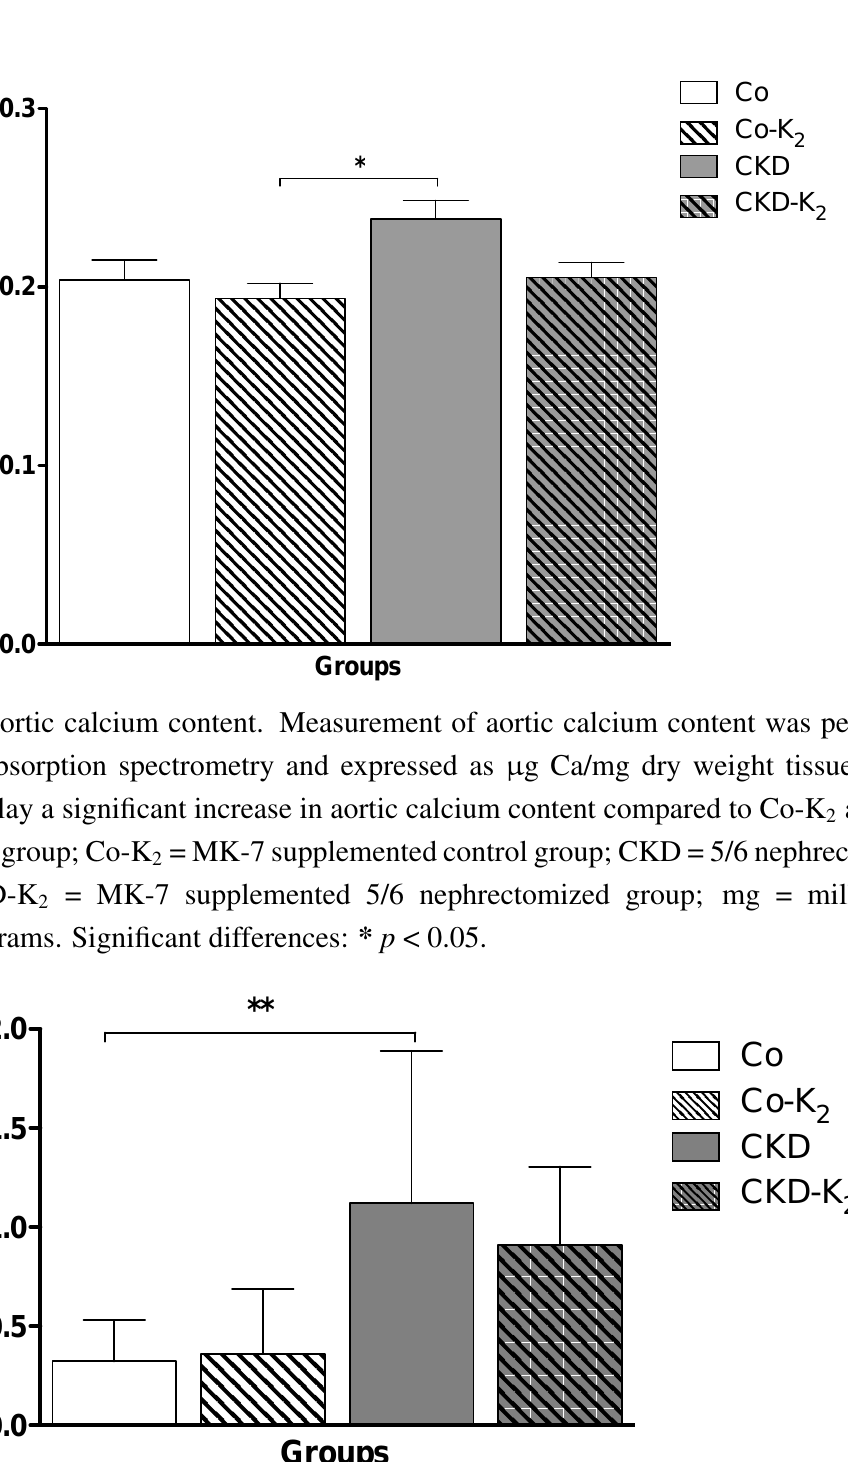
Figure 3. Alkaline phosphatase (ALP) in aortic tissues. ALP was measured to detect local vascular osteochondrogenic activity. Positive staining for ALP is expressed as product score: ALP-positive staining areal × intensity. ALP-product-score is significantly increased in CKD animals as compared to Co animals. Co = control group; Co-K 2 = MK-7 supplemented control group; CKD = 5/6 nephrectomized group; CKD-K 2 = MK-7 supplemented 5/6 nephrectomized group. Significant differences: ** p < 0.01.